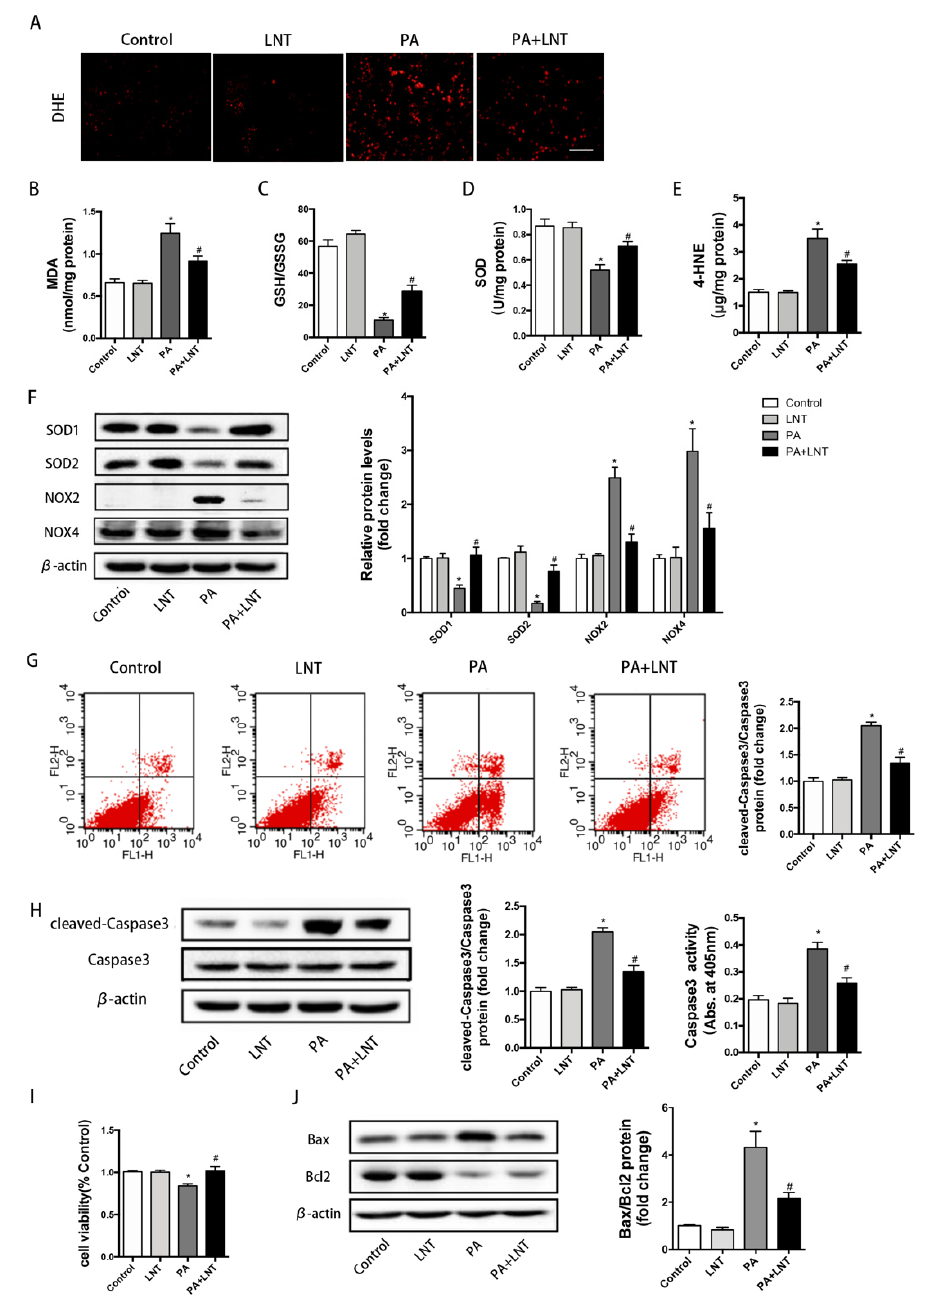
Figure 4. LNT improved oxidative stress and apoptosis in PA-induced AML12 cells. ( A ) DHE staining of AML-12 cells. ( B – E ) MDA, GSH/GSSH, SOD, and 4-HNE levels in AML-12 cells. ( F ) Representative Western blots and quantification of SOD1, SOD2, NOX2, and NOX4 in AML-12 cells. ( G ) Representative annexin-V-FITC/PI staining and quantification of apoptosis by flow cytometry. ( H ) Cleaved-Caspase3 expression by Western blot analysis and Caspase3 activity in AML-12 cells. ( I ) Cell viability of AML-12 cells. ( J ) Representative Western blots and quantification for apoptosis-related proteins in AML-12 cells. Data are presented as the mean ± SEM ( n = 3 per group). * p < 0.05 compared with the Control group. # p < 0.05 compared with the PA group.